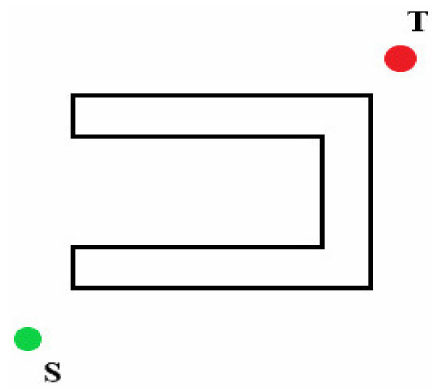
Figure 1. U-shaped